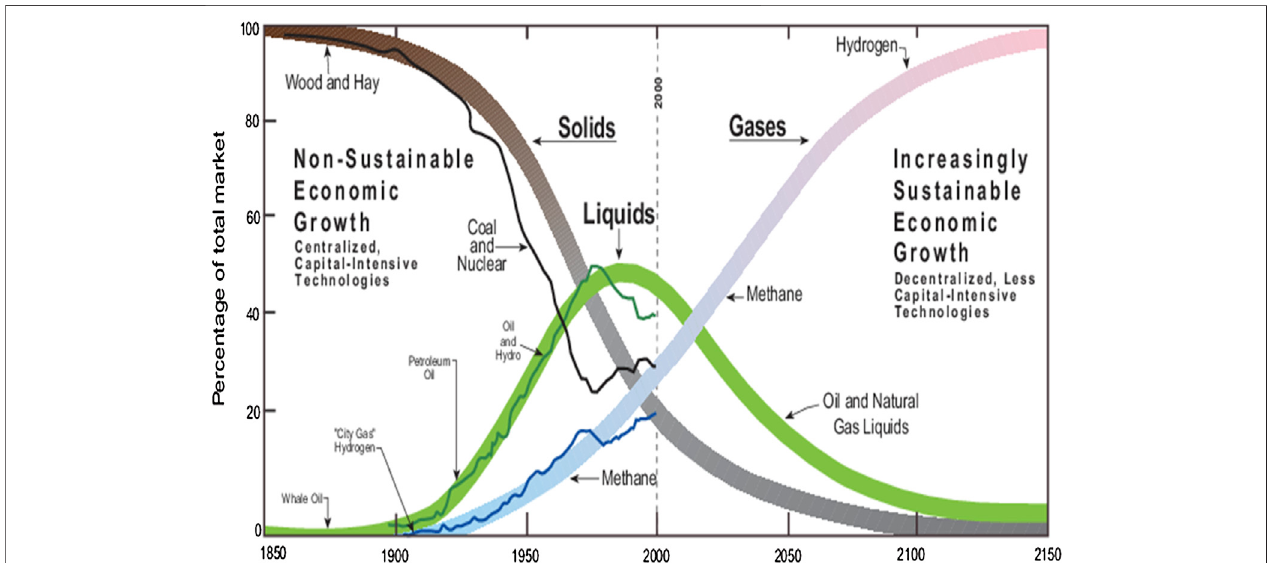
FIGURE 1 | Global transition of energy systems 1850 – 2150 (Dunn,